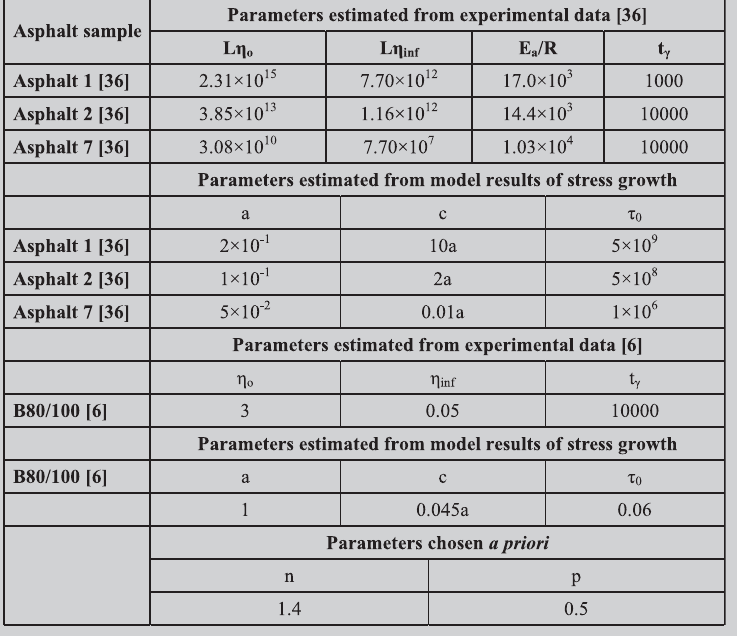
Table 1: Parameters used with the model [6, 36]. Figure 1: Shear rate dependence of the viscosity (parameters listed in Table 1, for Asphalt